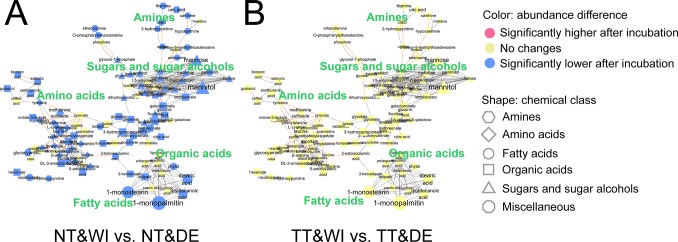
MetaMapp analysis of the effects of water incubation on the profiles of 113 metabolites identified in pooled urinary metabolome samples which were (A) thermally not treated or (B) thermally treated.Group NT&WI: thermally not treated, incubated with water without urease, and extracted with pure methanol; group NT&DE: thermally not treated and extracted with pure methanol without urease pretreatment; group TT&WI: thermally treated, incubated with water without urease, and extracted with pure methanol; group TT&DE: thermally treated and extracted with pure methanol without urease pretreatment. Classes of metabolites are represented by shapes. Significant increases and decreases in the abundance of metabolites after incubation with water are indicated by colors (p < 0.05, based on the Wilcoxon signed-rank test with FDR adjusted via the Benjamini–Hochberg correction). Magnitudes of fold changes are represented by the sizes of symbols and labels; biochemical and structural similarities are represented by orange and gray edges, respectively.